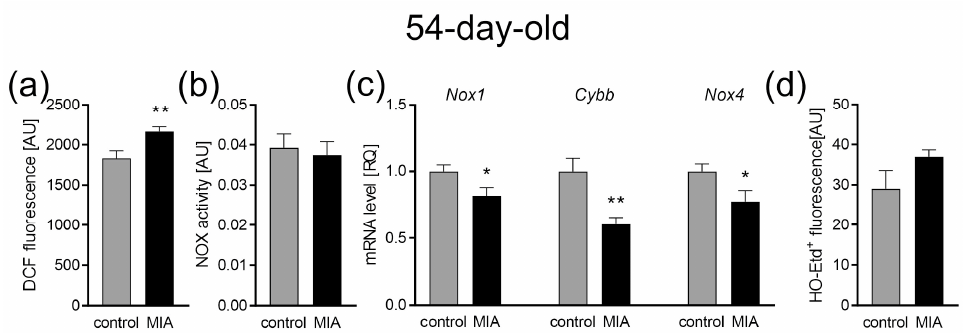
Figure 7. The effect of MIA on oxidative stress in the brains of 54-day-old offspring. ( a ) The level of reactive oxygen species was determined with DCFH-DA probe (n = 8). ( b ) The level of NADPH oxidase (NOX) activity (n = 9 and 6). ( c ) The mRNA level of NOX subunits Nox1 (n = 6), Cybb (n = 5 and 6), and Nox4 (n = 5 and 6) was determined using real-time PCR with Actb ( β -actin) as a reference gene. ( d ) The generation of superoxide radicals was determined by the fluorimetric method using DHE (n = 4). Data represent the mean value ± S.E.M. and were analyzed using Student’s t -test. * p < 0.05, ** p < 0.01, compared with the control